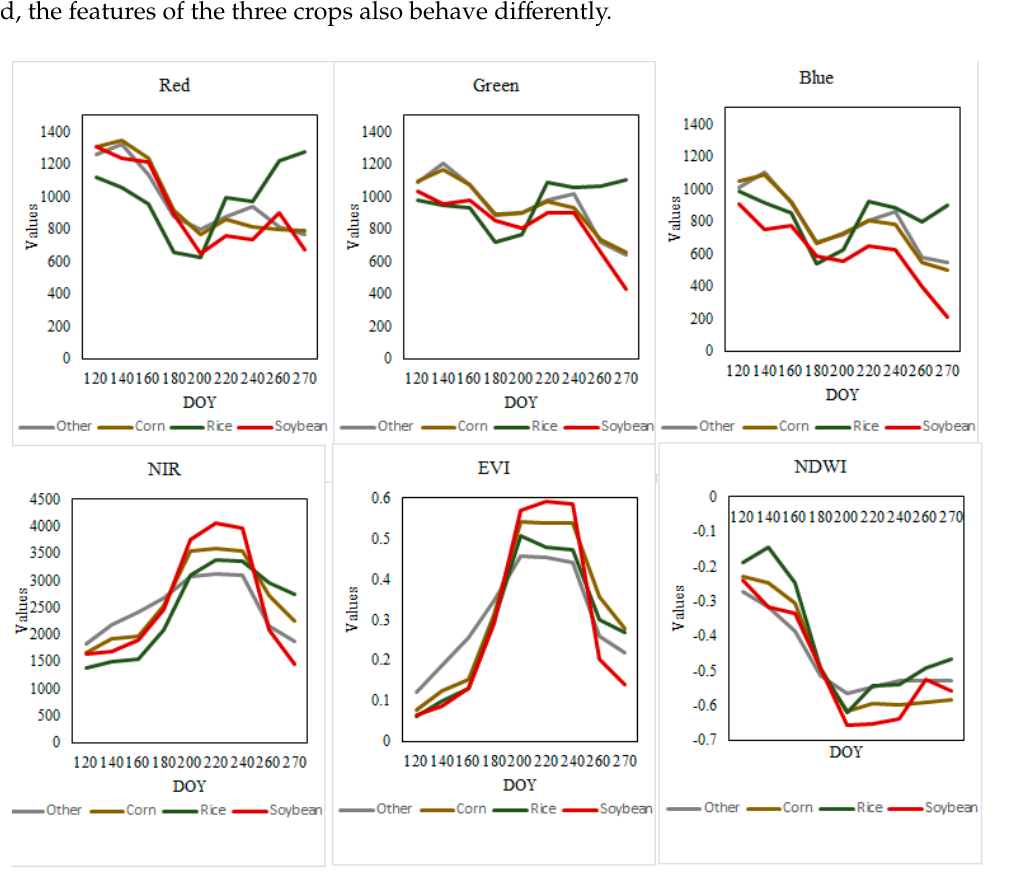
Figure 7. Temporal profile based on the blue, green, red and NIR bands as well as the EVI and NDWI and the timing curves of the corn, rice, and soybean growth periods. and the timing curves of the corn, rice, and soybean growth